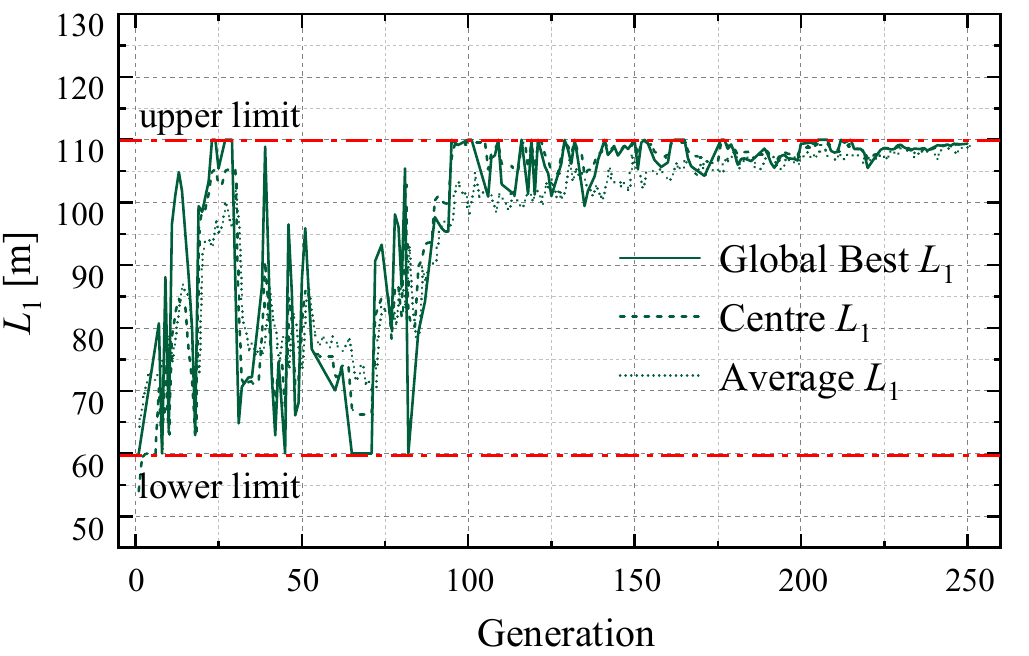
Figure 19. The convergence progress of radius of exit curved segment: R 4.